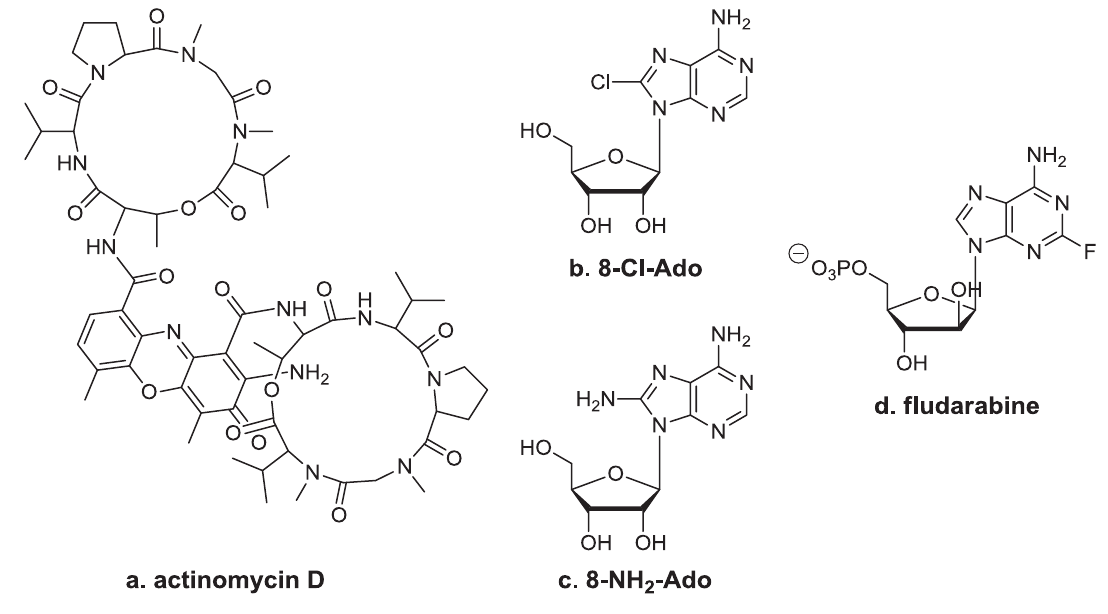
Figure 3. Inhibitors of RNA chain synthesis. Structures of ( a ) actinomycin D, ( b ) 8-Cl-Ado, ( c ) 8-NH -Ado, and ( d ) 2